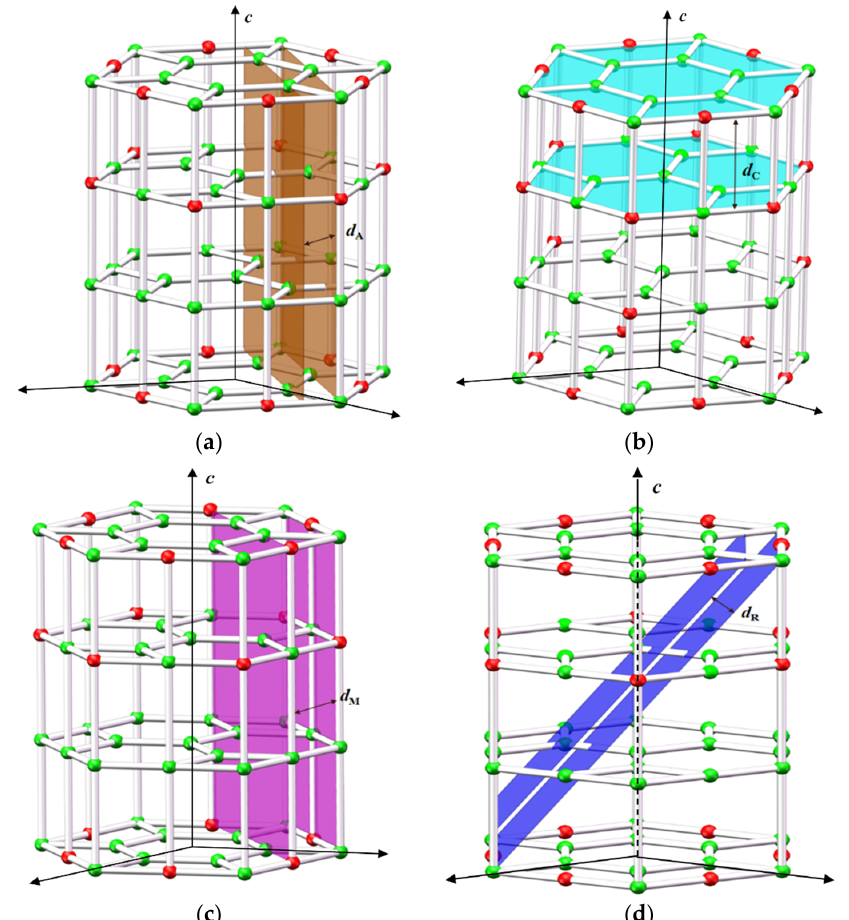
Figure 8. Crystal models of the four crystal orientations for the ( a ) A-plane, ( b ) C-plane, ( c ) M-plane and ( d ) R-plane.